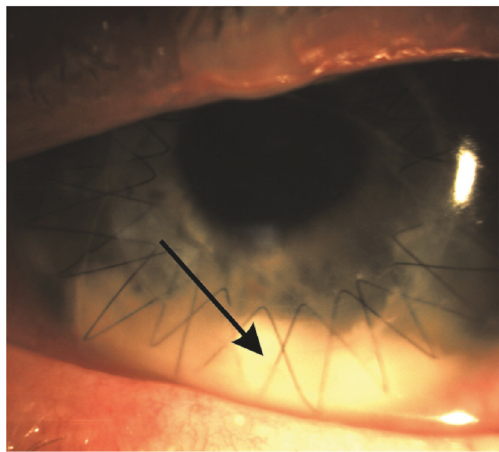
Figure 1: The right eye of 34-year-old white male on day zero of the penetratingkeratoplasty.Noteabsenceofthecornealoedema.White materialatthebottom(blackarrow),irregularlyborderedsuperiorly to the rest of the clear anterior chamber.